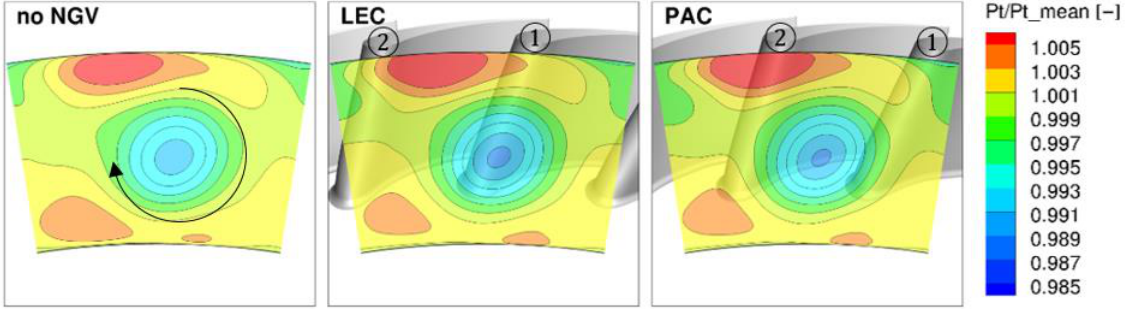
Figure 10. Normalized pressure in P40.